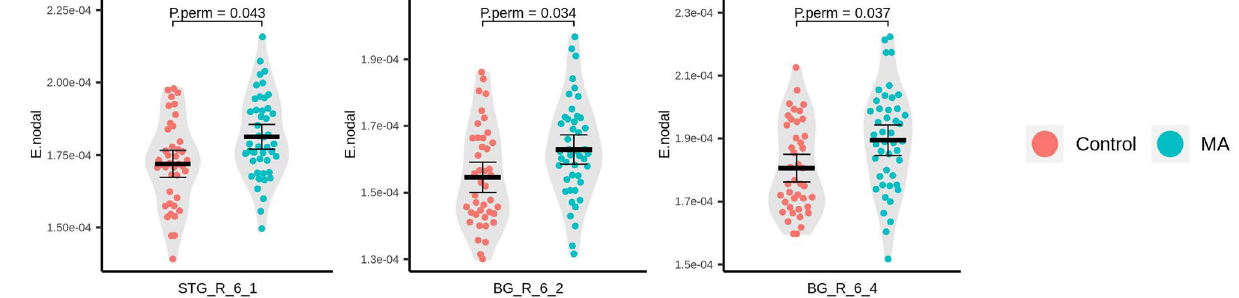
Figure 2. Brain regions with significant differences in nodal efficiency between methamphetamine-dependent patients and healthy controls. STG_R_6_1 = the weighted nodal efficiency of the right medial superior temporal gyrus; BG_R_6_2 = the weighted nodal efficiency of the globus pallidus; BG_R_6_4 = the weighted nodal efficiency of the ventromedial putamen. MA: methamphetamine-dependent patients; control: healthy controls.